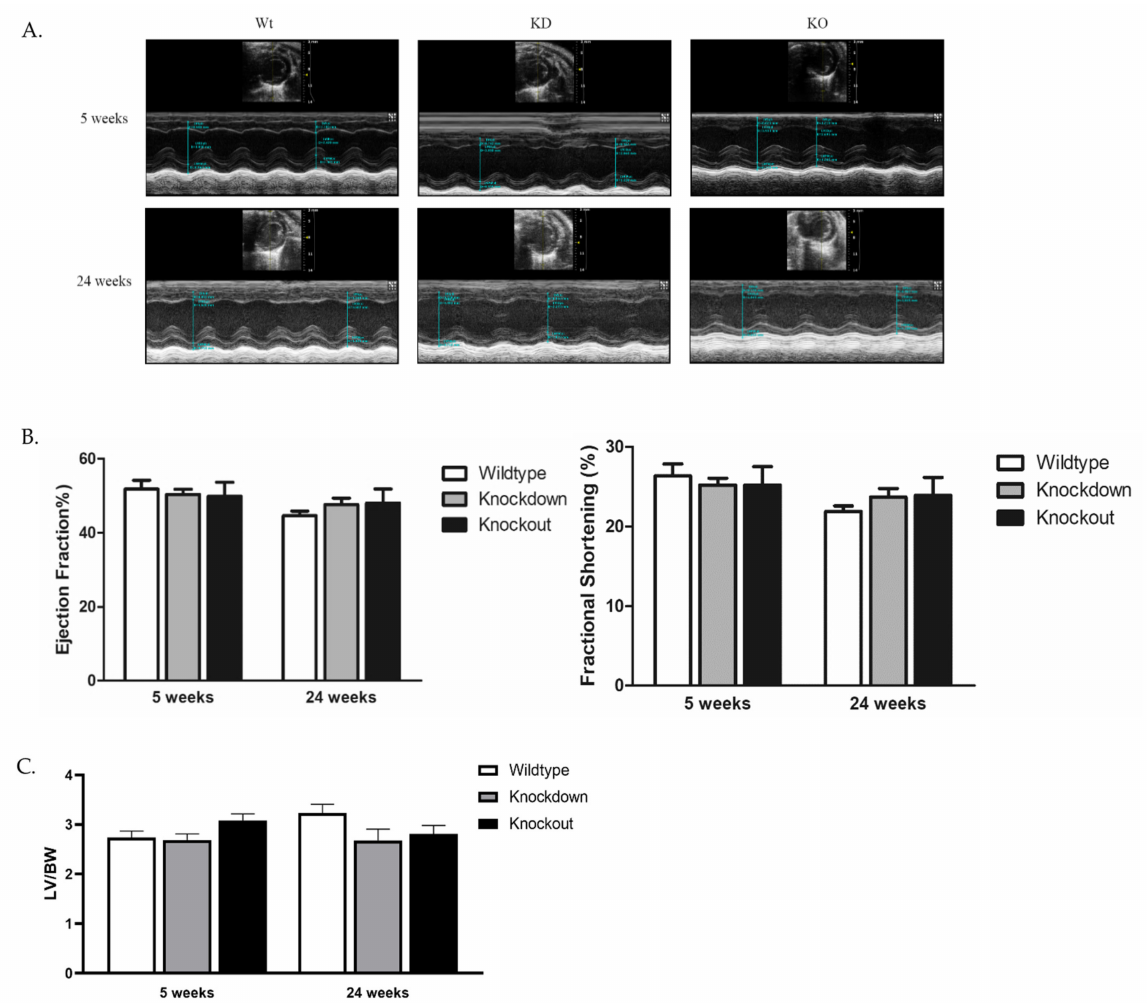
Figure 6. Echocardiography and left ventricular function of SLMAP3-deficient hearts. ( A ) Representative short-axis m-mode images of Wt, KD and KO hearts at 5 weeks and 24 weeks post tamoxifen. ( B ) Bar graphs represent cardiac functional analysis via ejection fraction (%) and fractional shortening (%) of young and aged SLMAP3-deficient hearts. ( C ) The bar graph represents left ventricle mass to body weight ratio (LV/BW) in Wt, KD and KO mice. n =